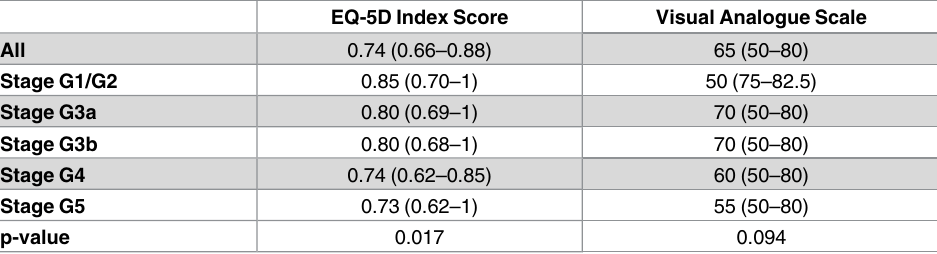
Table 3. Calculated EQ-5D Index Score and Visual Analogue Scale by CKD